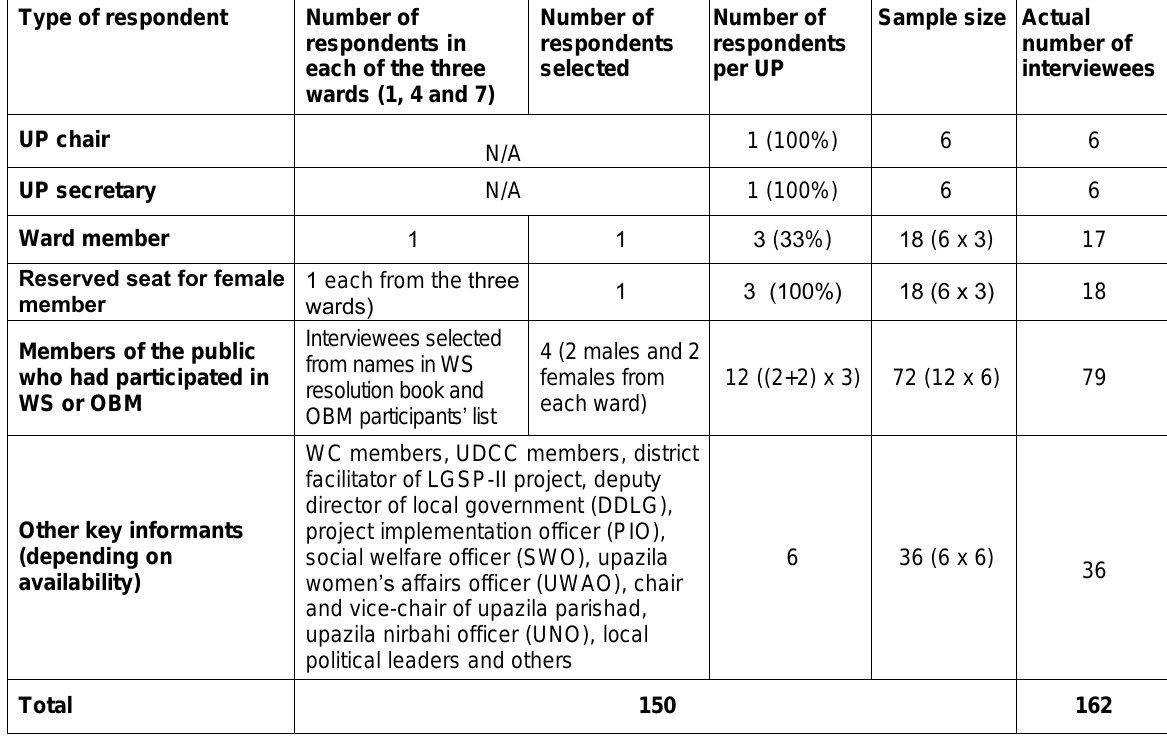
Table 2: Respondents of the study Type of